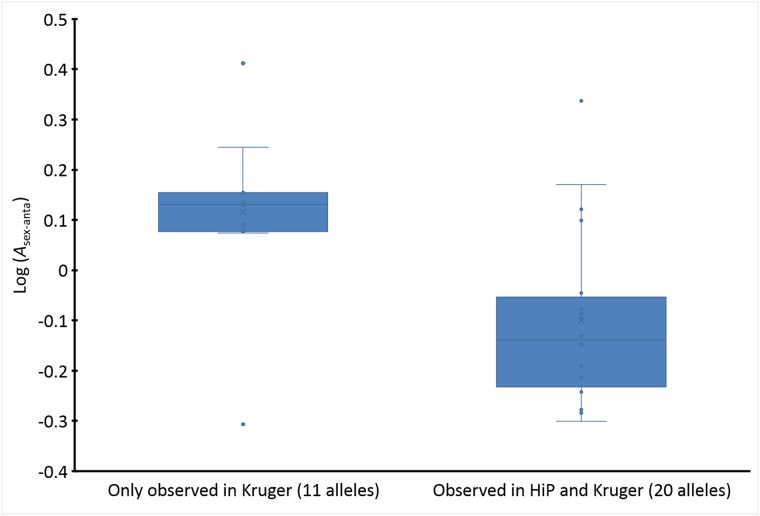
Difference in Asex-anta between SAEindvO alleles from Kruger observed and not observed in HIP.Median difference = 0.27, P = 0.0049. Test 2, Table 2.